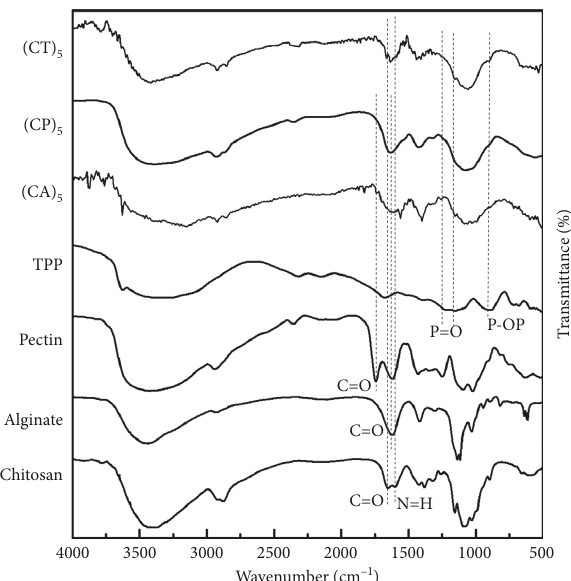
Figure 4: FTIR (Fourier transform infrared spectroscopy) of coating layer.